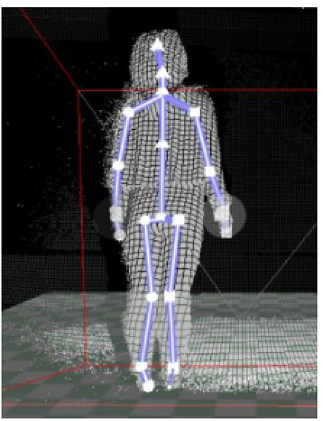
Figure 5. Human skeleton captured by Kinect.